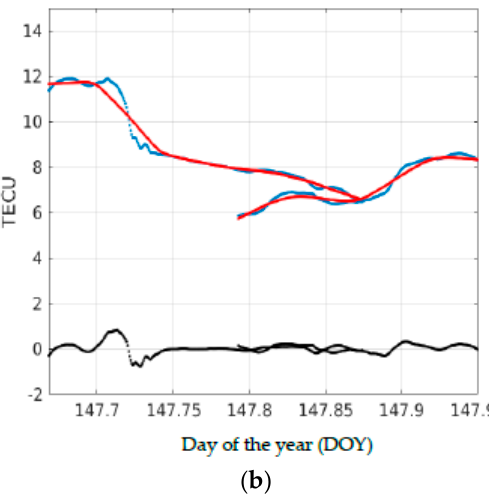
Figure 1. ( a ) An example of ionospheric pierce point distribution of the total electron content (TEC) measurement on 8 May 2017 at 10:00 UT. The black line represents the magnetic equator. ( b ) Examples of traveling ionospheric disturbances (TID) analysis procedures. The blue line represents the background TEC from one station and two satellites, the red line represents the hourly sliding window using the Savityky–Golay low-pass filter, and the back line represents the differential TEC ( ∆ TEC). The line of sight TEC (STEC) was converted to vertical TEC (VTEC) at the pierce point of